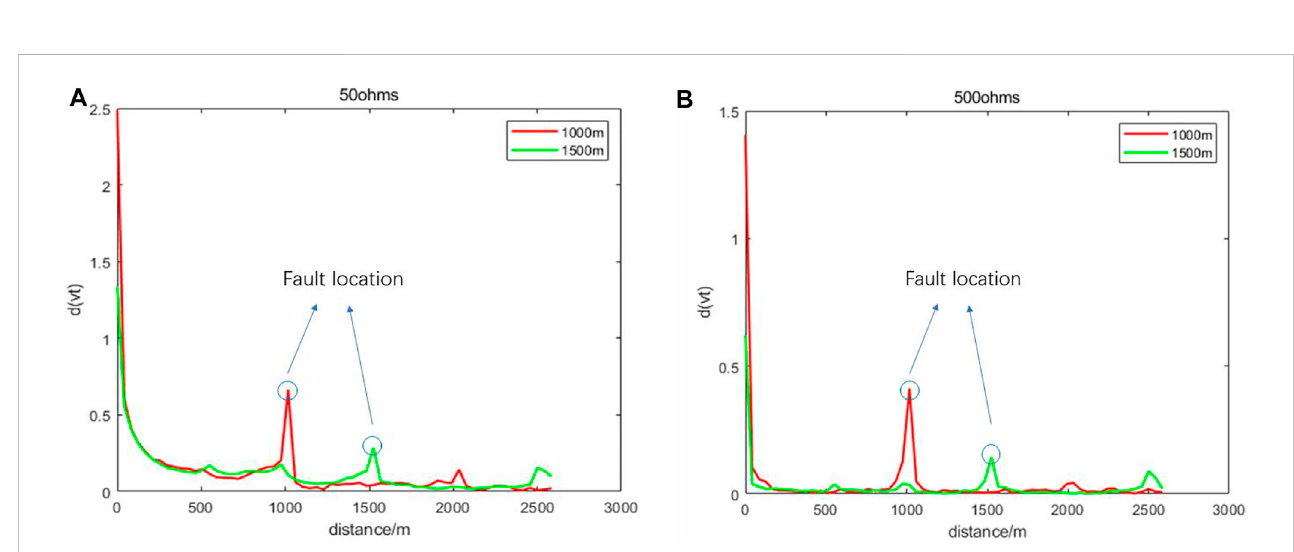
FIGURE 14 Positioning effect under different conditions. (A) is the fault location effect under LIF. (B) is the fault location effect under HIF.